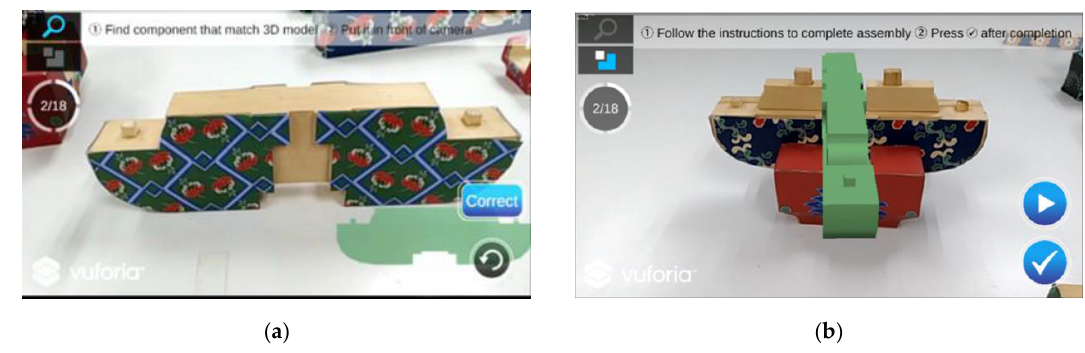
Figure 9. Once the current step is completed, the user will need to click the next button to take the next step. A similar operation repeats until the entire assembly process is completed. Appl. Sci. 2020 , 10 , x FOR PEER REVIEW